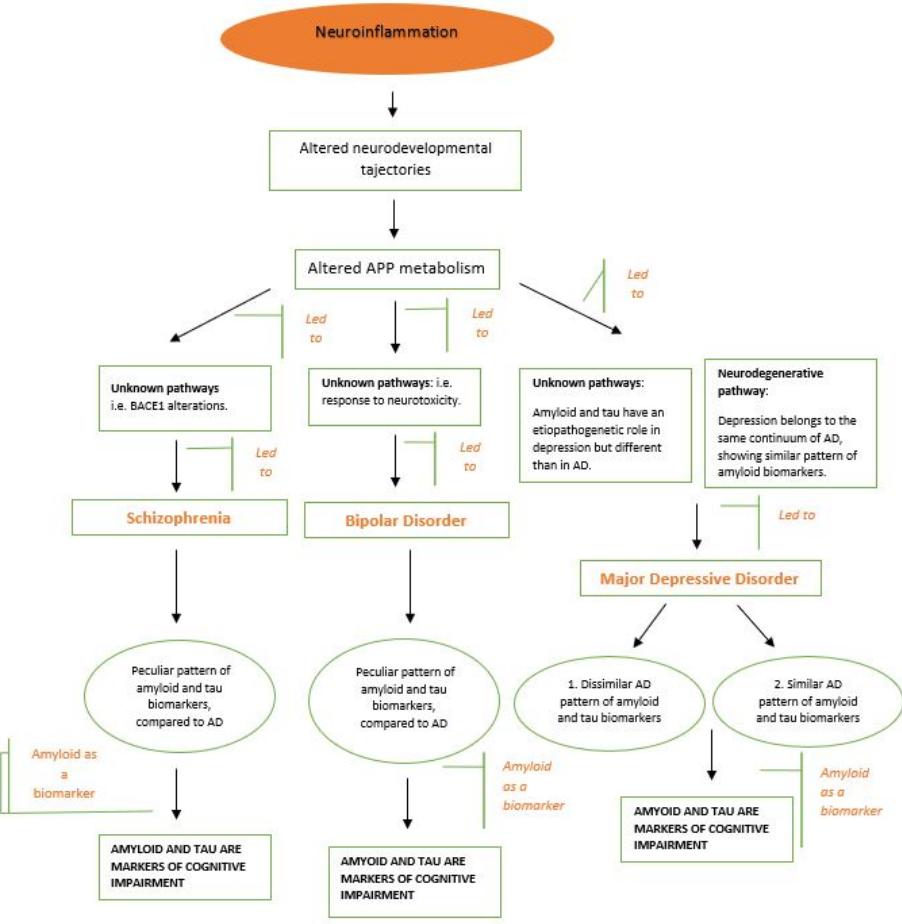
Figure 3. Hypothetical role of APP in the pathogenesis of mental illness, with differences among three of the major mental disorders. The process of neuroinflammation, which led to an altered APP metabolism, might be made up of different pathways for each mental pathology. Thus, whereas in schizophrenia, the pathway could be an alteration in BACE1 and in bipolar disorder it could be a response to neurotoxicity, depression might be influenced by two distinct ways—a neurodegenerative pathway (similar to AD) and an unknown pathway (different from